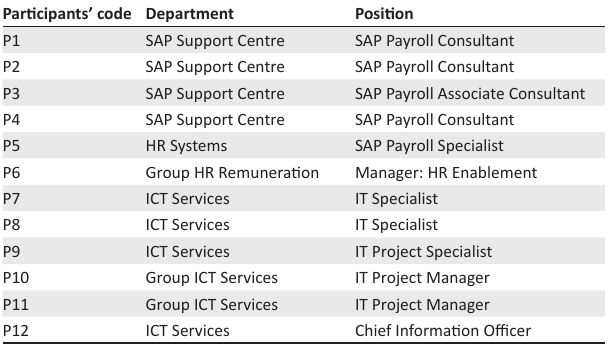
TABLE 3: Breakdown of participants contributed in the study.